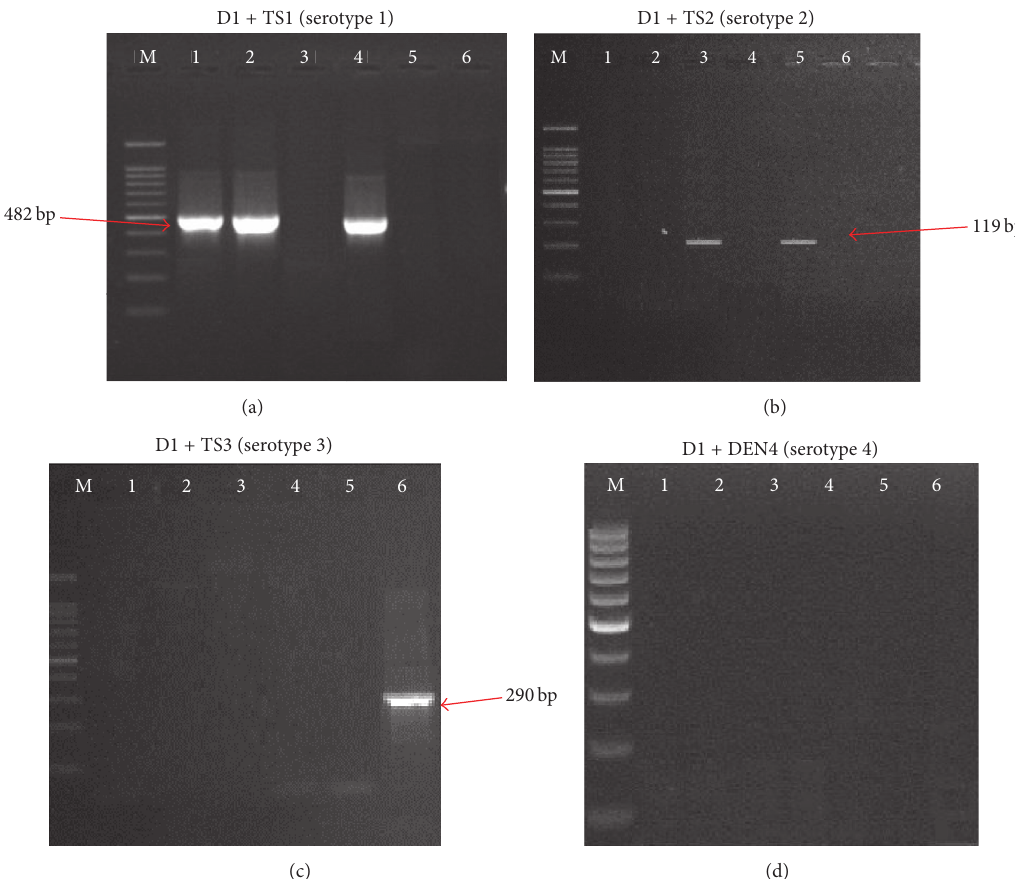
Figure 1: Identification of dengue virus serotypes by the specific primers. Four sets of specific primers were (a) D1 and TS1 for DENV-1, (b) D1 and TS2 for DENV-2, (c) D1 and TS3 for DENV-3, and (d) D1 and DEN4 for DENV-4.